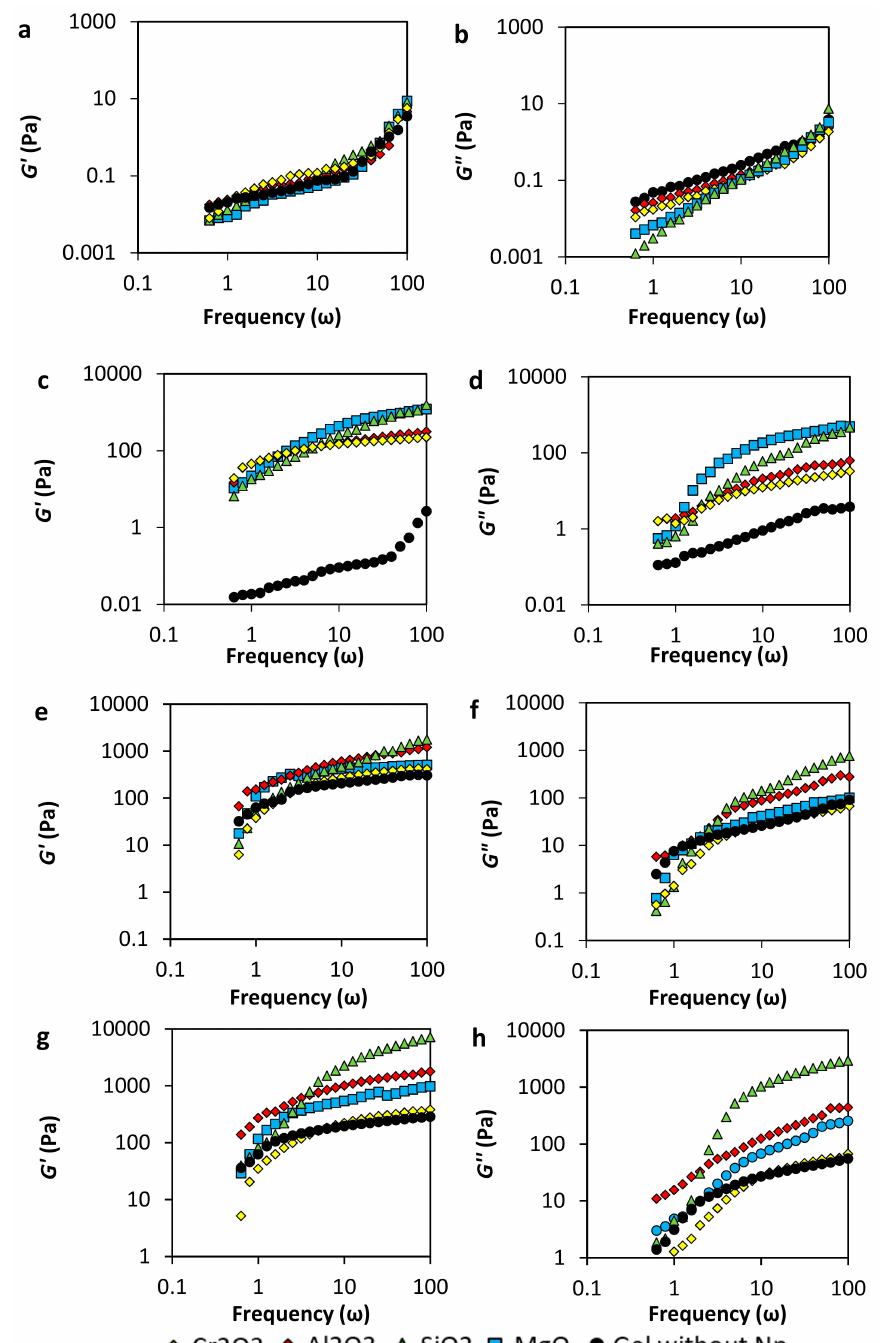
Figure 4. Storage moduli ( G’ ) and loss moduli ( G” ) of acrylamide / sodium acrylate copolymer / chromium IIIacetategelsystematafixeddosageof100mg · L -1 ofAl 2 O 3 , MgO,Cr 2 O 3 , SiO 2 nanoparticles,